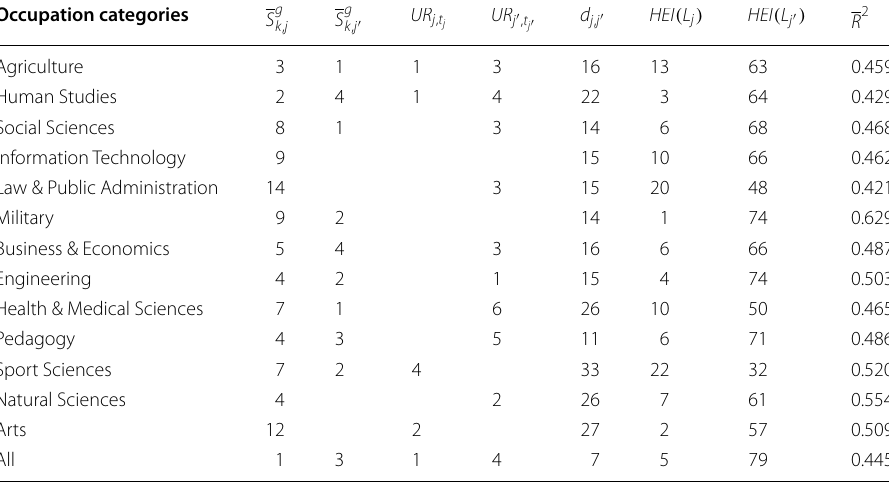
Table 9 Variable importance (in %) of occupation mobility model Occupation